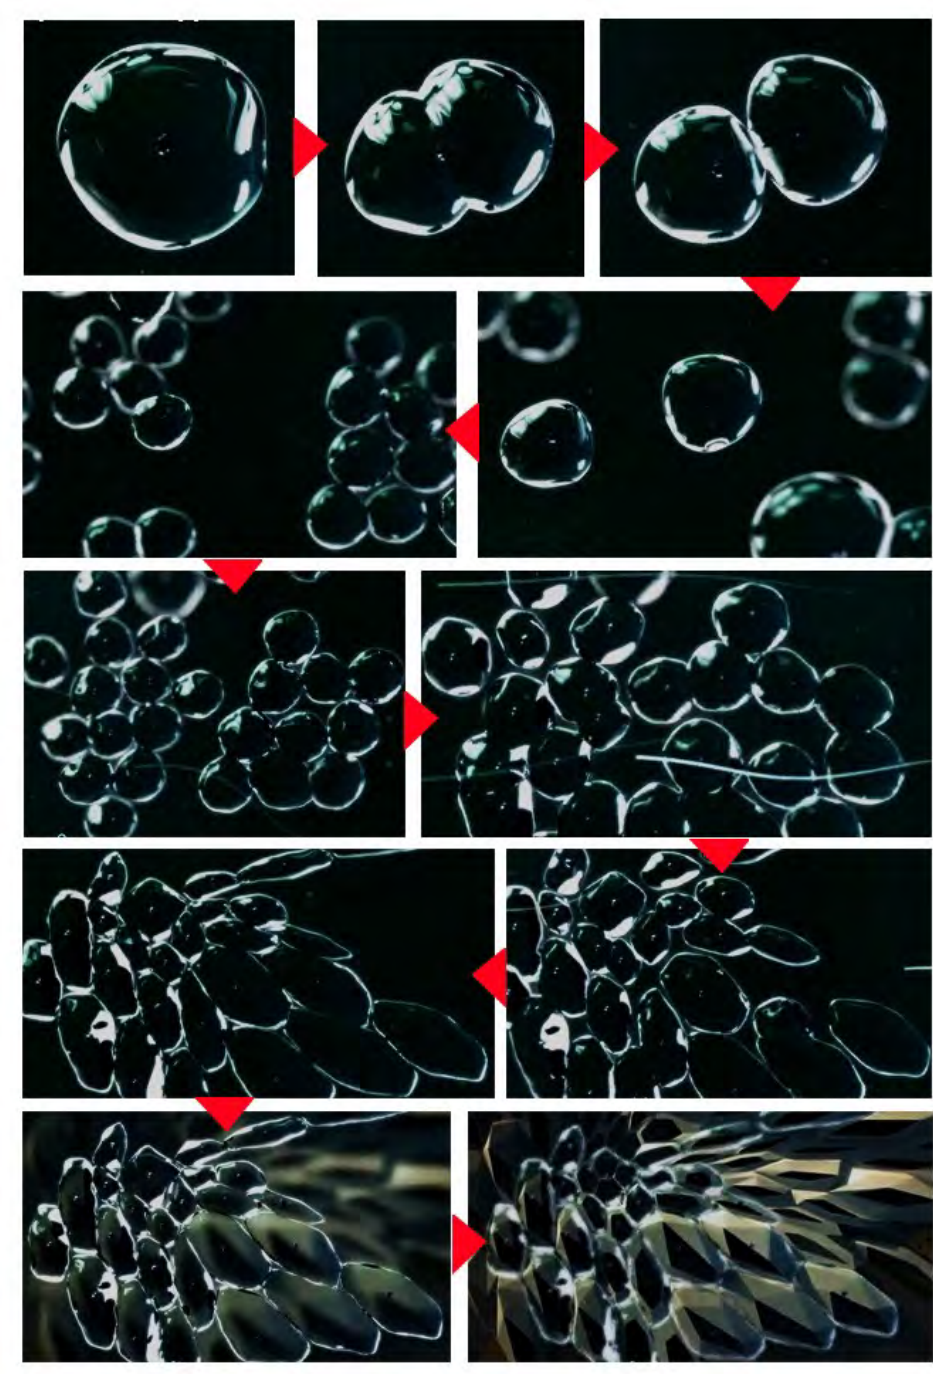
Figure 10. Thedivision mechanism of fractal cells at King Abdullah Petroleum studies &research center